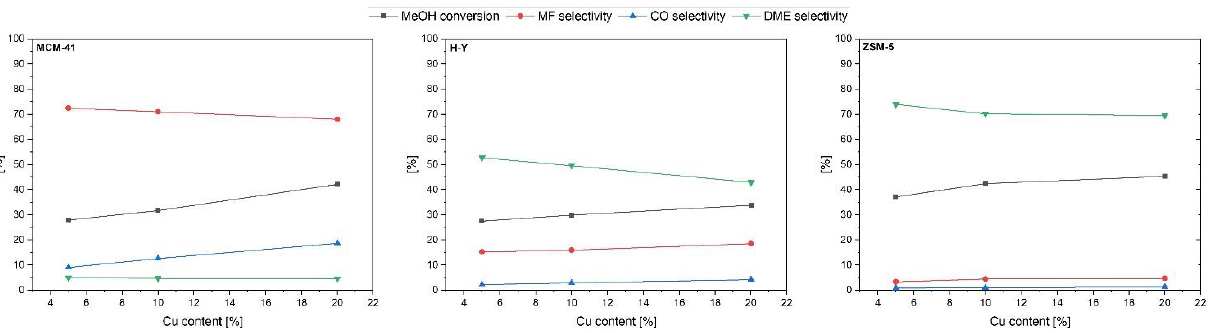
Figure 4. Influence of the Cu-content of different zeolite-based Cu-catalysts on methanol conversion and selectivity of MF, CO and DME [28].